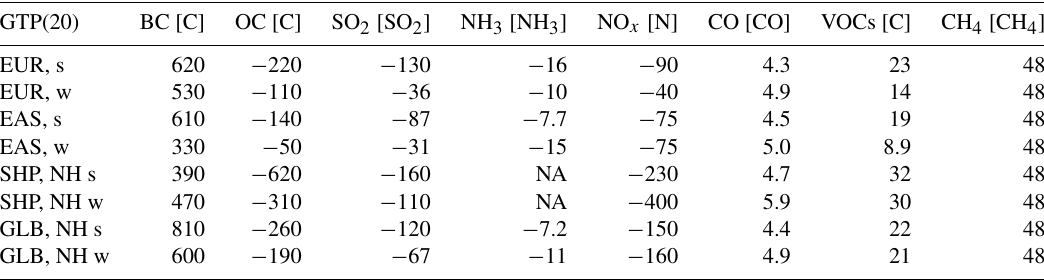
Figure 3. GWP(100) values for the ozone precursors, for all regions and seasons, decomposed by processes. The regions included are Europe (EUR), East Asia (EAS), shipping (SHP), and global (GLB), all for both NH summer (s), May–October, and NH winter (w), November– April. How the best estimate of the net effect is calculated is given in Sect. 2.1. The uncertainty bars show the range across models, which is not given for shipping as the best estimate is based on only two models for that sector. Table 2. The best estimate given for GTP(20) values. The component of each species which the mass emission refers to is shown in brackets. The regions are Europe (EUR), East Asia (EAS), shipping (SHP), and global (GLB), for emissions occurring in NH summer (s), May– October, and NH winter (w),